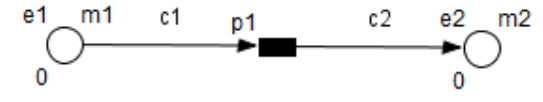
Figure 3. Discrete entities, discrete process and normal